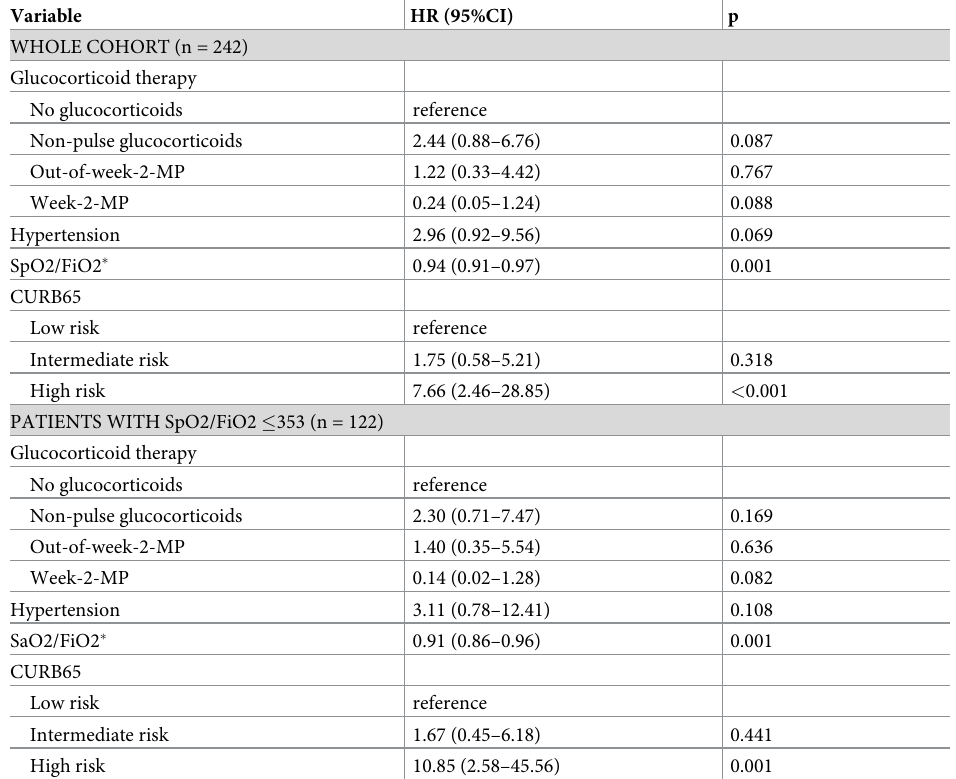
Table 5. Predictors of death: final models using the type of glucocorticoid